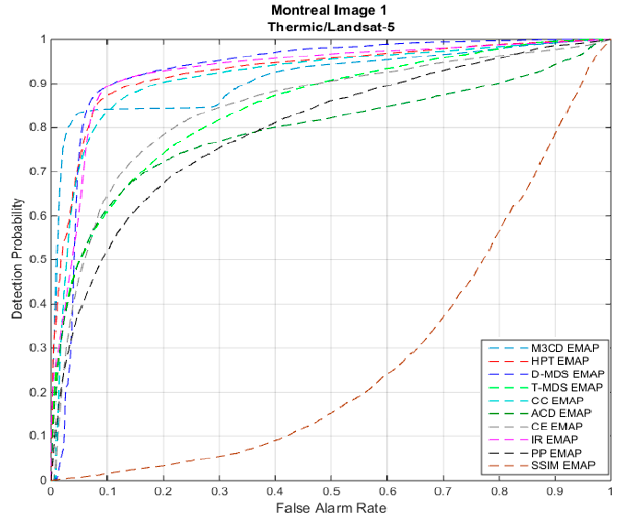
Figure 7. ROC curves for Image Pair-2 without EMAP.